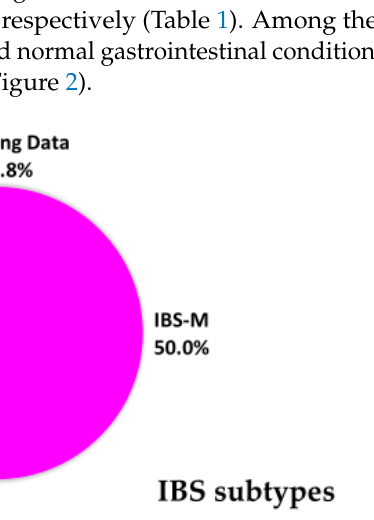
Figure 1. Distribution of IBS subtypes IBS-C: IBS with predominant constipation, IBS-D: IBS with predominant diarrhea, IBS-M: IBS with mixed bowel habits, IBS-U: IBS unclassified.